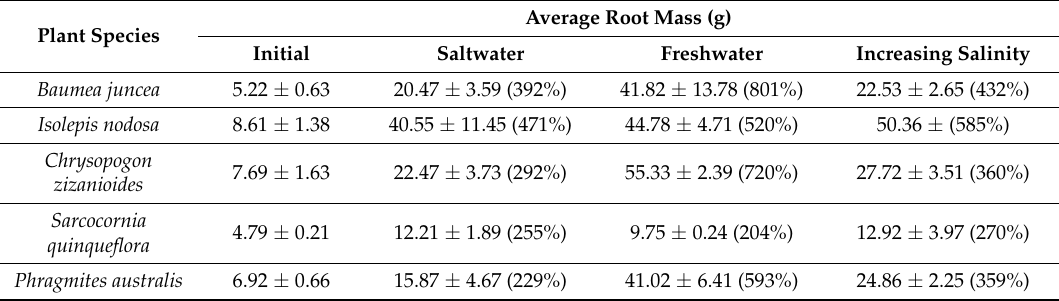
Table 3. Initial Tubestock Root Mass and Final Plant Root Mass for Each Species in Each Water Treatment (Percentage Change in Root Mass Shown in Brackets).